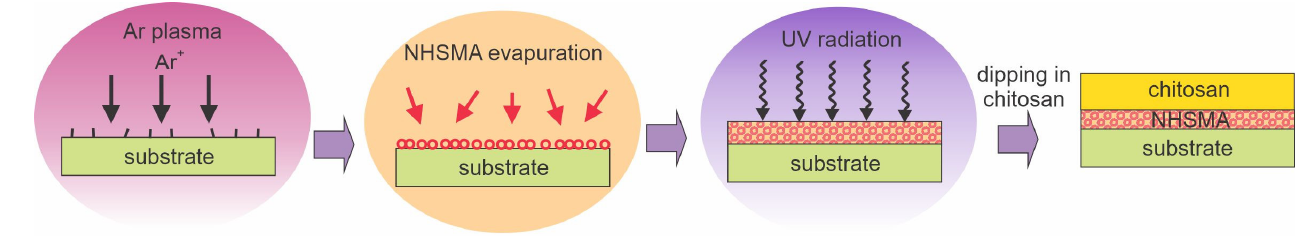
Figure 11. A method for immobilizing a chitosan film using the following steps: formation of dangling bonds by bombardment with Ar ions, evaporation of NHSMA, cross-linking of the deposited film by UV radiation, and dipping in an acidic aqueous solution of chitosan.